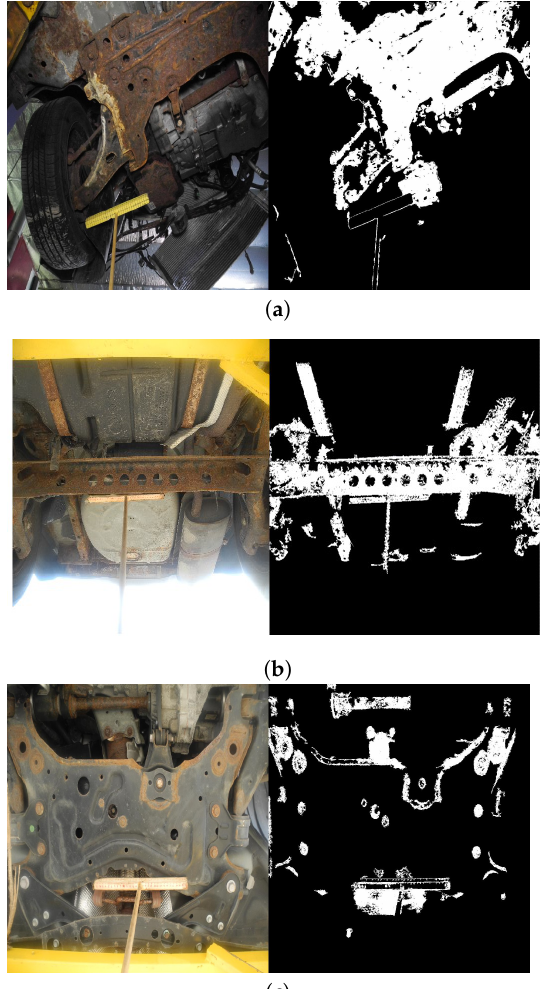
Figure 6. Illustration of corrosion detection and quantification. ( a ) Surface Rust Percent = 39.08%; ( b ) Surface Rust Percent = 21.42%; ( c ) Surface Rust Percent =